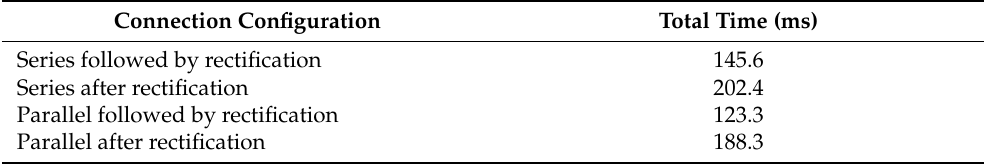
Table 3. Total time with generator voltage is above 4 V, with different coil combinations.